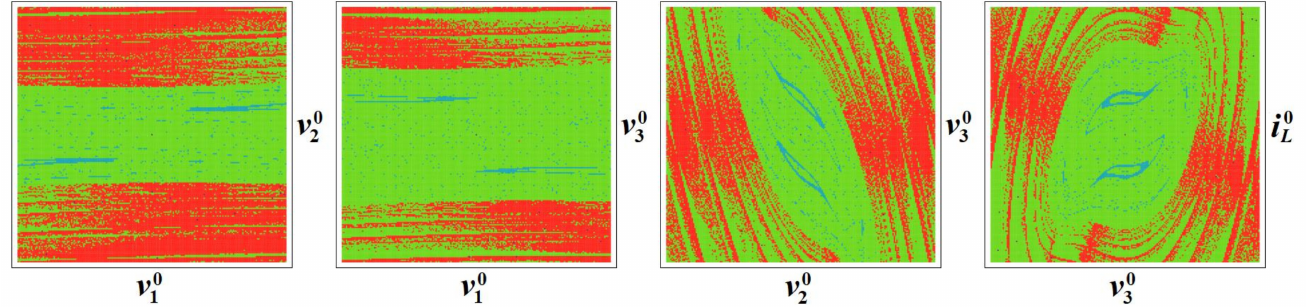
Figure 10. Resonant amplifier with Darlington-type cell, analysis of fourth order system, colored basins of attraction. See text for clarification of the individual plots.